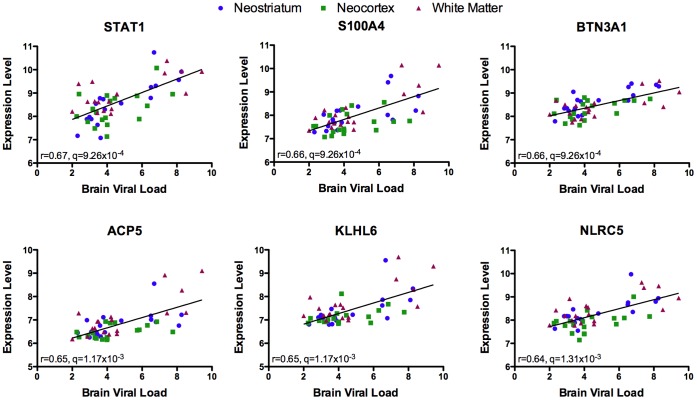
Correlation of gene expression with brain viral load.
STAT1, S100A4, BTN3A1, ACP5, KLJL6, and NLRC5 are gene symbols for the top six mRNAs that show significant correlation with brain viral load. The Pearson correlation coefficient (r) and p value are shown, along with a linear regression line modeling the correlation. The different brain regions are shown by different colored and shaped symbols.